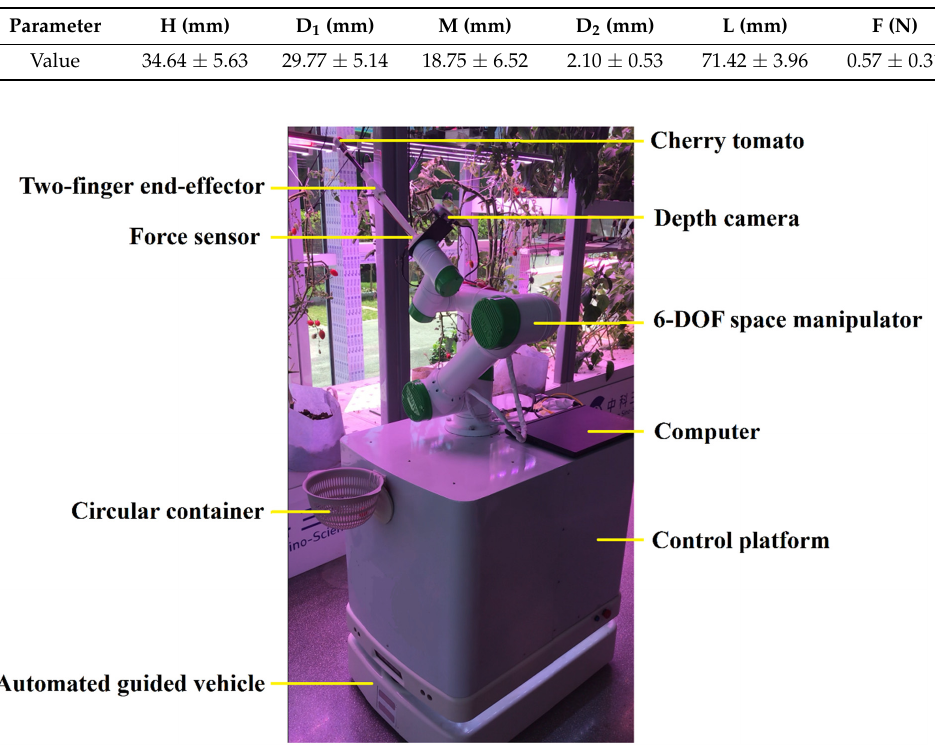
Figure 1. ( a ) The structure of a cherry tomato stem system; ( b ) physical measurements of cherry tomato basic shape parameters. Table 1. Results of basic shape parameters of cherry tomato samples (values are means ± standard deviations).